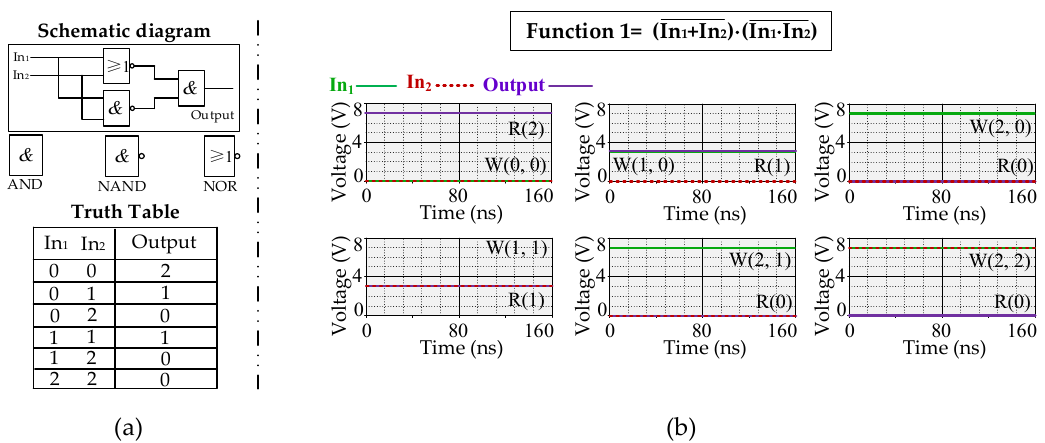
Figure 8. ( a ) The schematic diagram and truth table of function 1. ( b ) The circuit simulations of two cascaded ternary logic functions.